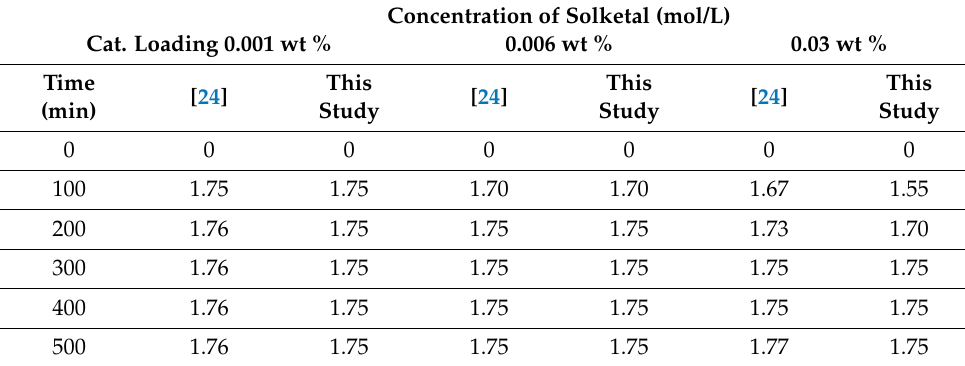
Table 9. Effect of catalyst concentration on solketal concentration in simulation model with study Dmitriev et al. Reproduced with the permission from [24], Springer,